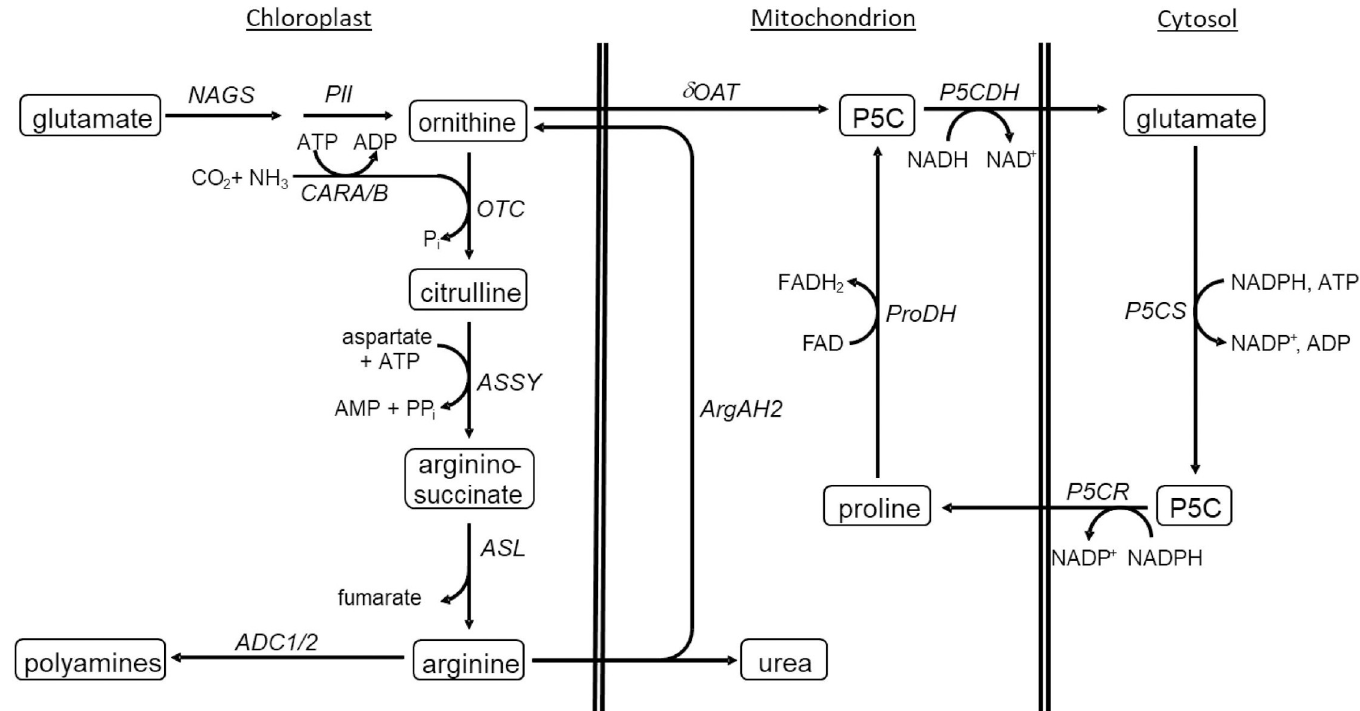
Fig 1. Overview on ornithine synthesis and degradation. ADC1/2, arginine decarboxylase 1 and 2; ArgAH, arginine amidohydrolase; ASL, argininosuccinate lyase; ASSY, argininosuccinate synthetase; CARA, carbamoyl phosphate synthetase A; CARB, carbamoyl phosphate synthetase B; NAGS, N-acetyl-L-glutamate synthase; δ OAT, ornithine- δ -aminotransferase; OTC, ornithine transcarbamylase; PII, PII protein; P5CDH, pyrroline-5-carboxylate dehydrogenase; P5CS, pyrroline-5-carboxylate synthetase; P5CR, pyrroline-5-carboxylate reductase; PRODH, proline dehydrogenase.